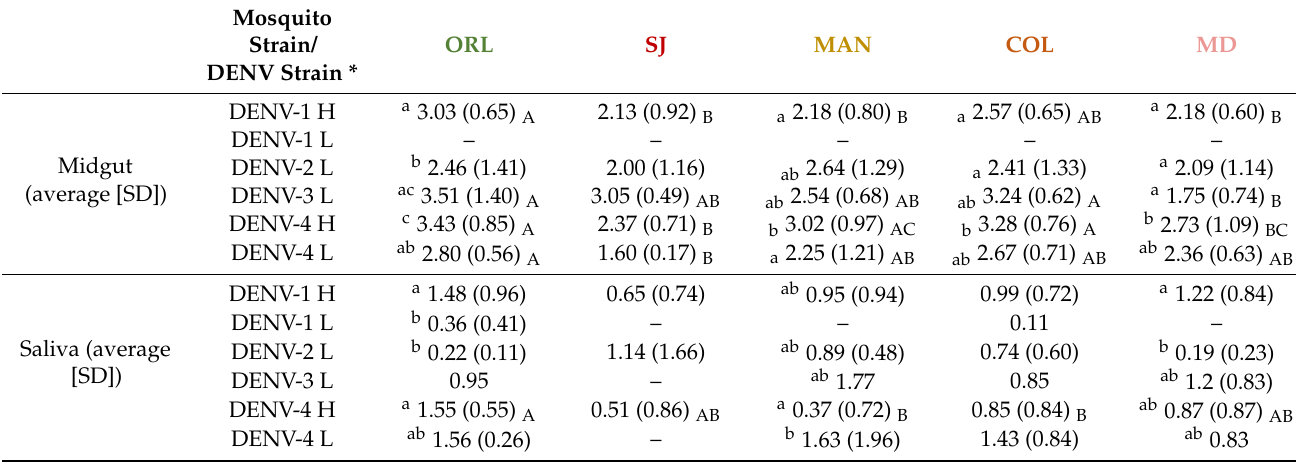
Table 2. Average DENV titer (log 10 PFU/mL) across Aedes aegypti strains in Florida reveals higher titers for the laboratory colony (ORL) as well as increased midgut titers for low passage